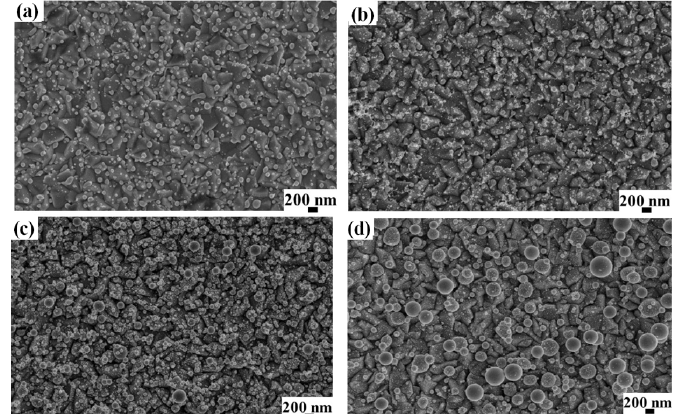
Figure 8. Representative SEM images, acquired near the laser spot center (i.e., region 3), of the nanoparticles formed by irradiating the AuPd film with thickness 4.3 nm ( a ), 7.5 nm ( b ), 29.2 nm ( c ), and 48.6 nm ( d ) deposited on the textured FTO substrate (substrate B).